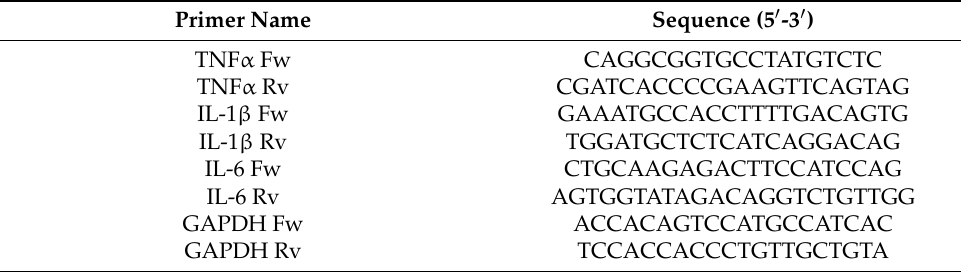
Table 1. The qPCR primers